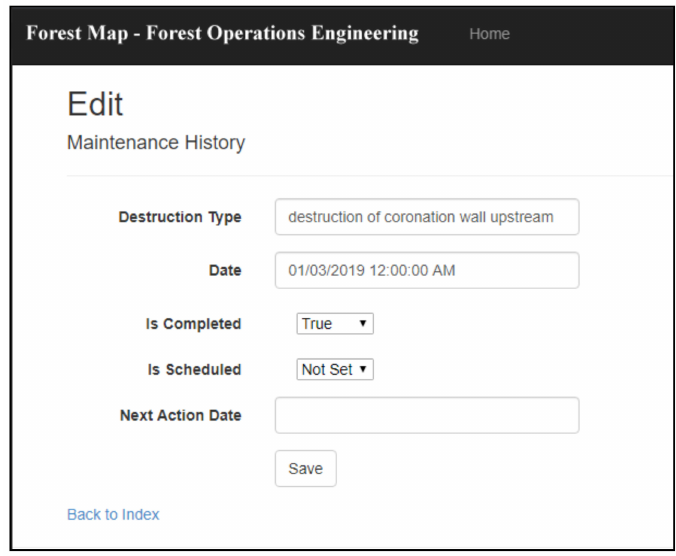
Figure 4. The “Edit” display screen of the web application tool.